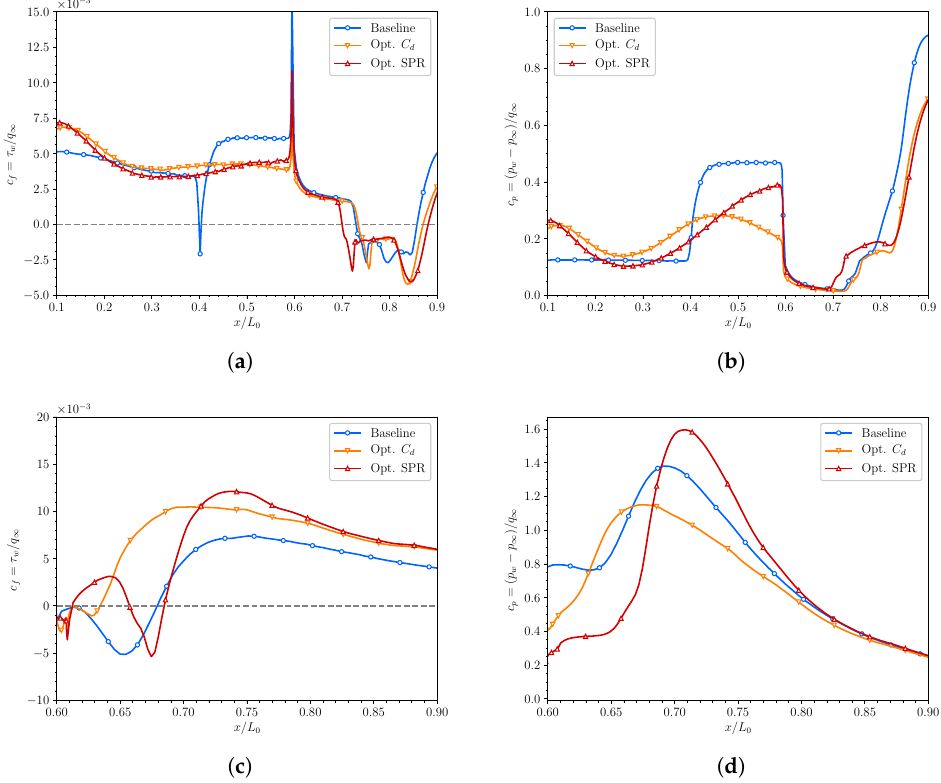
Figure 11. Comparison between the baseline and the optimal f 1 / f 2 friction and pressure coefficient trends along the bottom and the top surfaces. ( a ) Friction coefficient (bottom surface); ( b ) Pressure coefficient (bottom surface); ( c ) Friction coefficient (top surface); ( d ) Pressure coefficient (top surface). The pressure coefficient’s trend leads to similar conclusions to those reached so